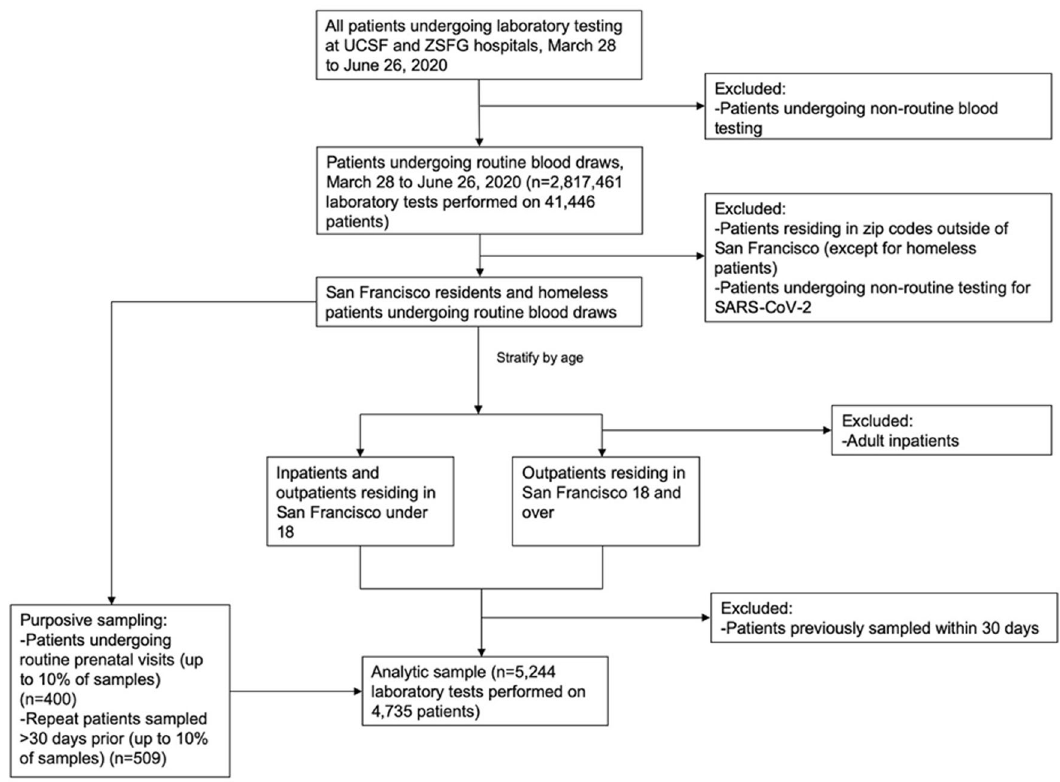
Fig. 1 Flow diagram of sampling algorithm. Flow diagram showing the inclusion and exclusion criteria used at different stages of the data screening and sample selection process.